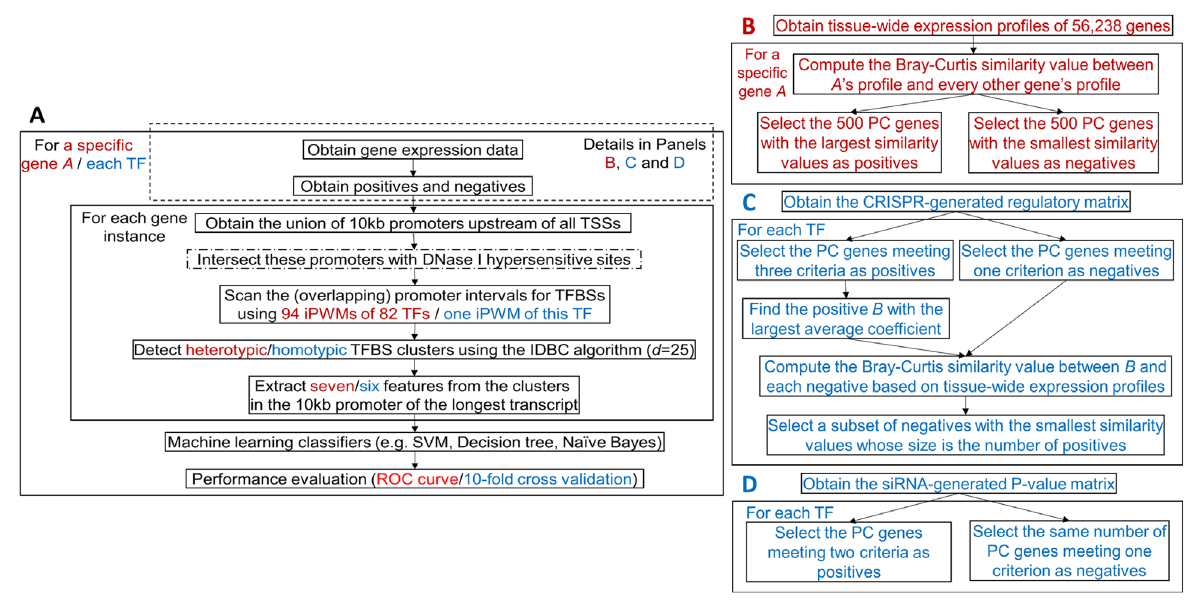
Figure 1. The general framework for predicting genes with similar tissue-wide expression profiles and TF targets. Red and blue contents are respectively specific to prediction of genes with similar tissue-wide expression profiles and prediction of TF targets. ( A ) An overview of the ML framework. The steps enclosed in the dashed rectangle vary across prediction of genes with similar tissue-wide expression profiles and TF targets. The step with a dash-dotted border that intersects promoters with DHSs is a variant of the primary approach. In the IDBC algorithm (Additional file 1 22 ), the parameter I is the minimum threshold on the total information contents of TFBS clusters. In prediction of genes with similar tissue-wide expression profiles, the minimum value was 939, which was the sum of mean information contents ( R values) of all 94 iPWMs; in prediction of direct targets, this value was the R value of the single iPWM used to sequence sequence detect TFBSs. The parameter d is the radius of initial clusters in base pairs, whose value, 25, was determined empirically. The seven ML features derived from TFBS clusters are described in the Methods section. The performance of seven different classifiers was evaluated with ROC curves and 10-fold cross validation (Additional file 1 22 ). ( B ) Obtaining the positives and negatives for identifying genes with similar tissue-wide expression profiles to a given gene (Additional file 2 22 ). ( C ) Obtaining the positives and negatives for predicting target genes of seven TFs using the CRISPR-generated perturbation data in K562 cells (Additional file 3 22 ). ( D ) Obtaining the positives and negatives for predicting target genes of 11 TFs using the siRNA-generated knockdown data in GM19238 cells (Additional file 4 22